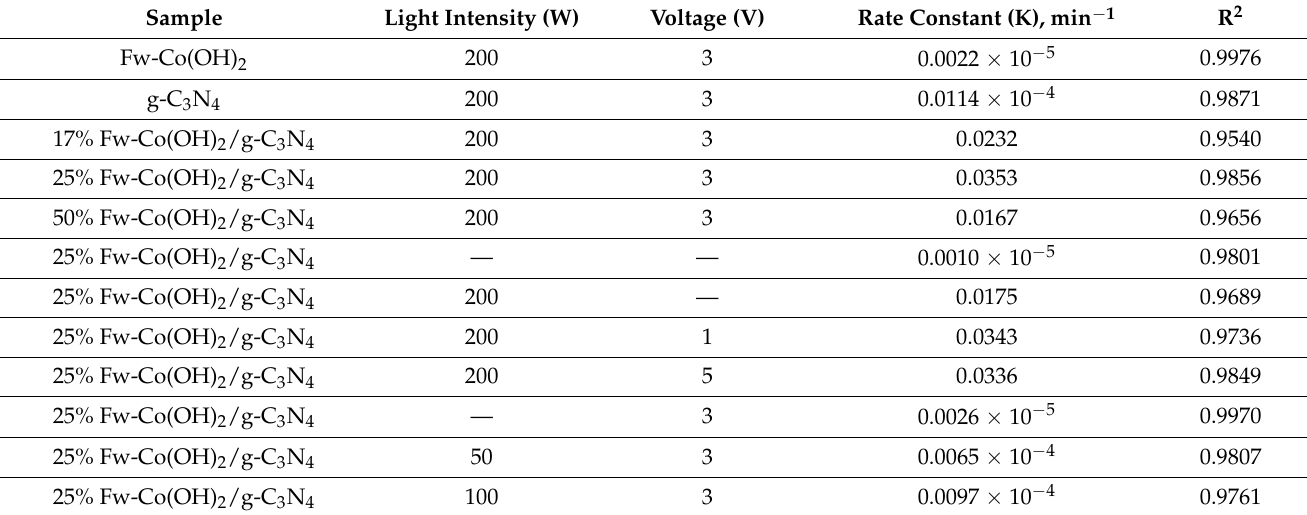
Table 1. The apparent pseudo-first-order rate parameters of Fw-Co(OH) 2 /g-C 3 N 4.